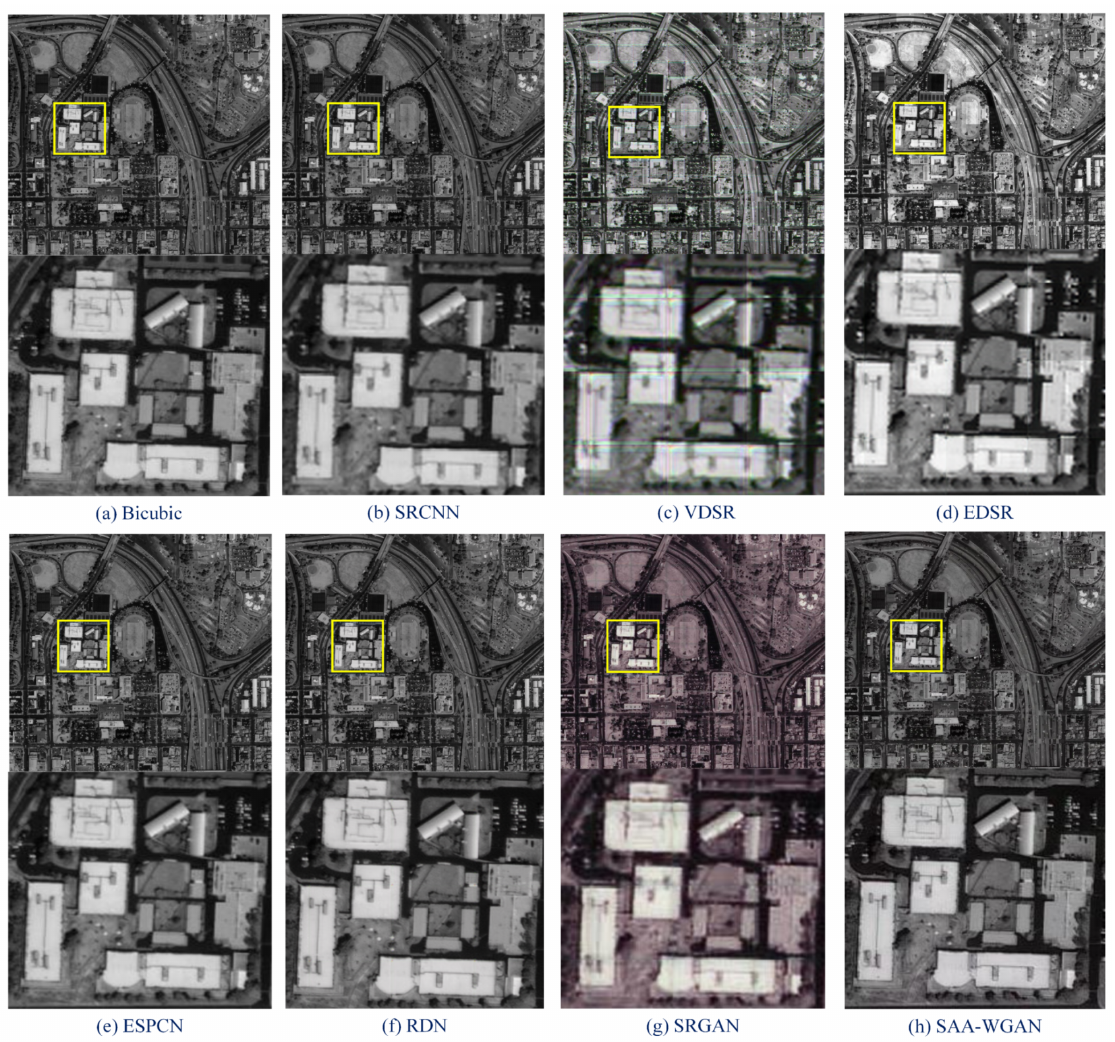
Figure 8. PAN image SR from GEO (scale = 4).